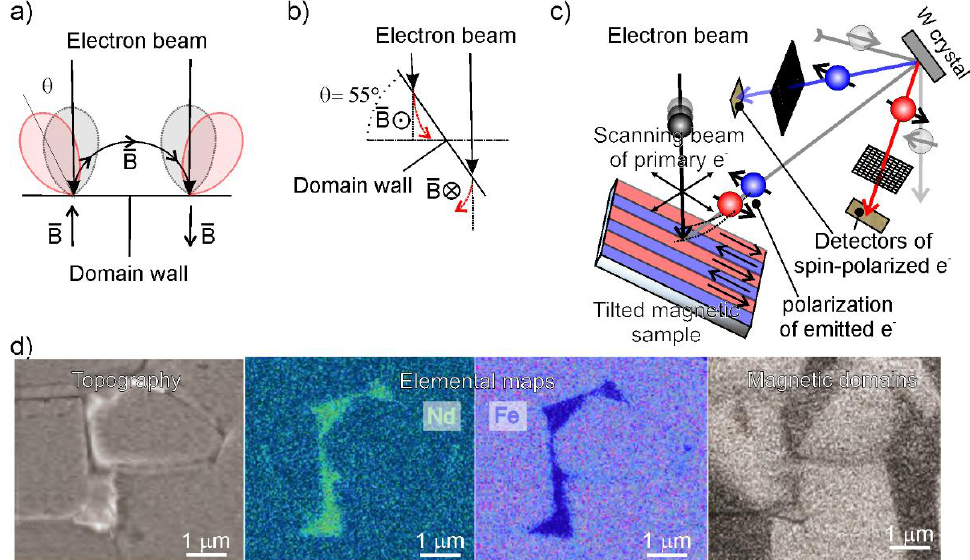
Figure 10. ( a – c ) representations of type-I, type-II, and type-III magnetism in SEM, corresponding to SE, BSE, and polarized electron detections, respectively; ( d ) Nd, Fe elemental distributions (left panels), topography and magnetic domain images (right panels) of a NdFeB permanent magnet. Element maps were acquired by Auger spectroscopy. Panels in ( d ) are adapted from [116], published by Oxford Academic, 2013.